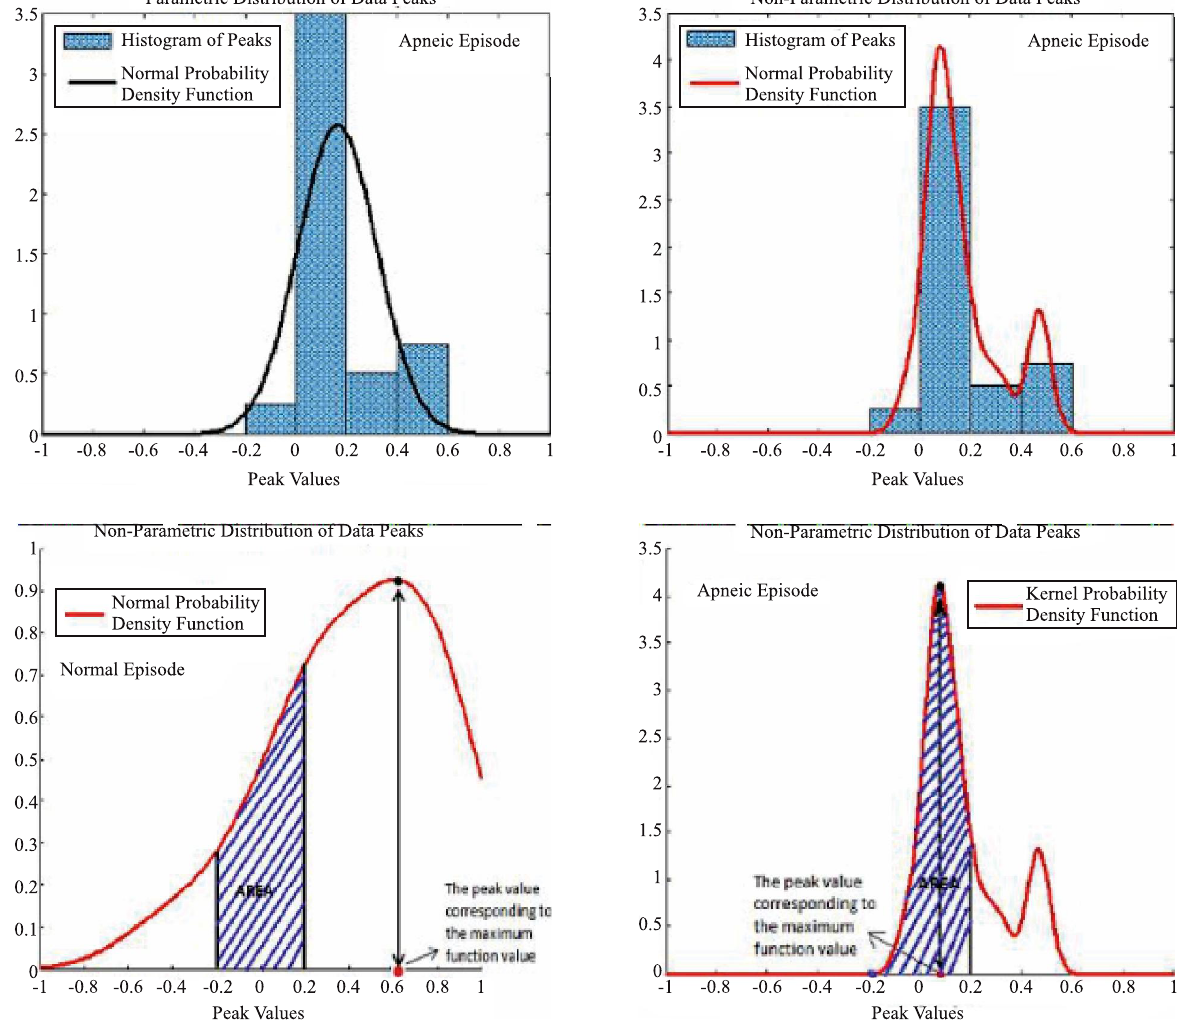
FIG. 5 . NORMAL, KERNEL, NON-PARAMETRIC AND HISTOGRAM DISTRIBITUONS OF DATA AND